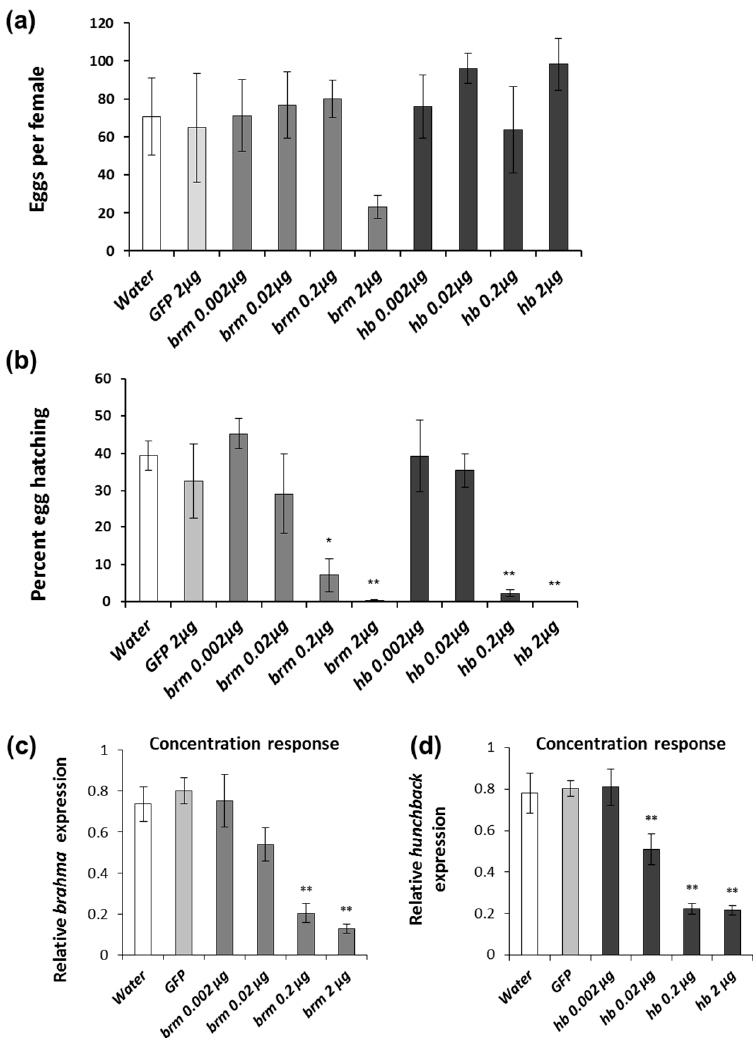
Figure 1. pRNAi concentration response to brahma ( brm ) and hunchback ( hb ) dsRNA in Diabrotica virgifera virgifera. Females were fed with diet treated with 0.002 µ g, 0.02 µ g, 0.2 µ g and 2 µ g brm or hb dsRNA. Diet treated with water or 2 µ g GFP dsRNA were used as controls. Treatments were applied six times every other day for twelve days. ( a ) Eggs collected from dsRNA-fed females after last feeding exposure; ( b ) Eggs hatched based on numbers oviposited; ( c , d ) Relative transcript level for brahma ( brm ) and hunchback ( hb ) in D. v. virgifera females. Comparisons performed with Dunnett ′ s test, * significance at p < 0.05. ** significance at p < 0.001 .